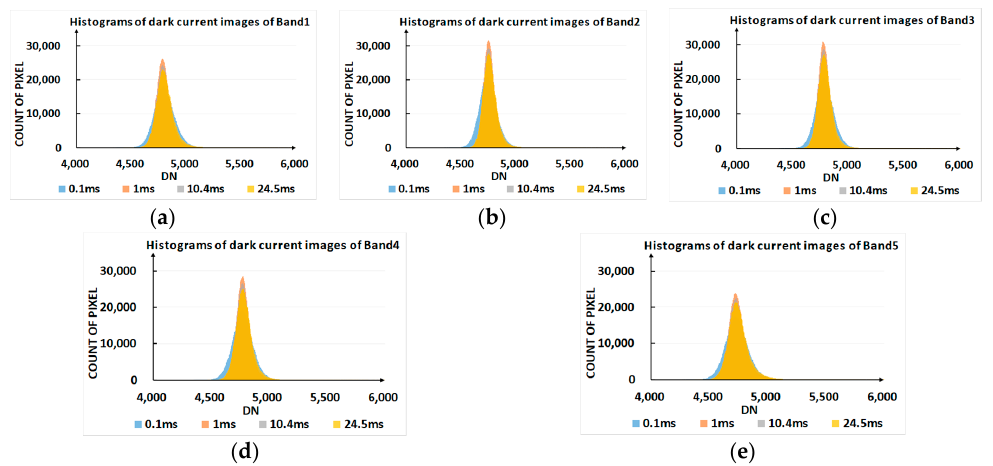
Figure 8. Histograms of dark current images at different integration times (0.1, 1.0, 10.4, and 24.5 ms) for various bands: ( a ) Band1; ( b ) Band2; ( c ) Band3; ( d ) Band4; ( e ) Band5.